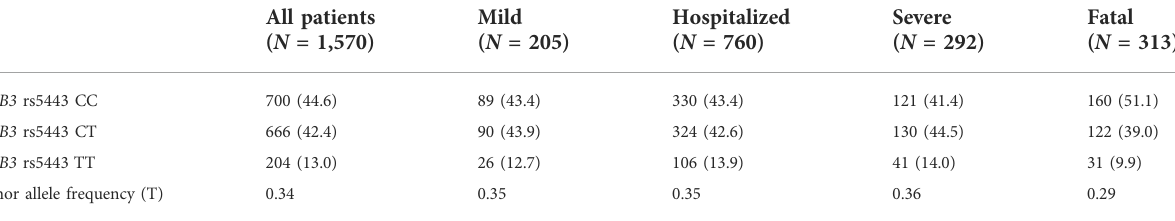
TABLE 2 GNB3 rs5443 (c.825C > T) genotype distribution among all patients with SARS-CoV-2 infection and subdivided according to the severity of COVID-19. All patients ( N =